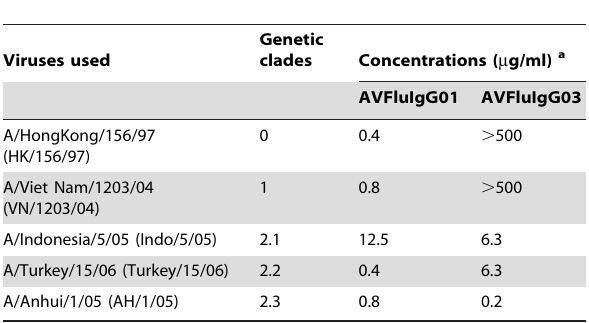
Table 3. Neutralization activity of recombinant human antibodies against H5N1 viruses isolated from China and other countries Genetic Viruses used clades Concentrations ( m g/ml) a